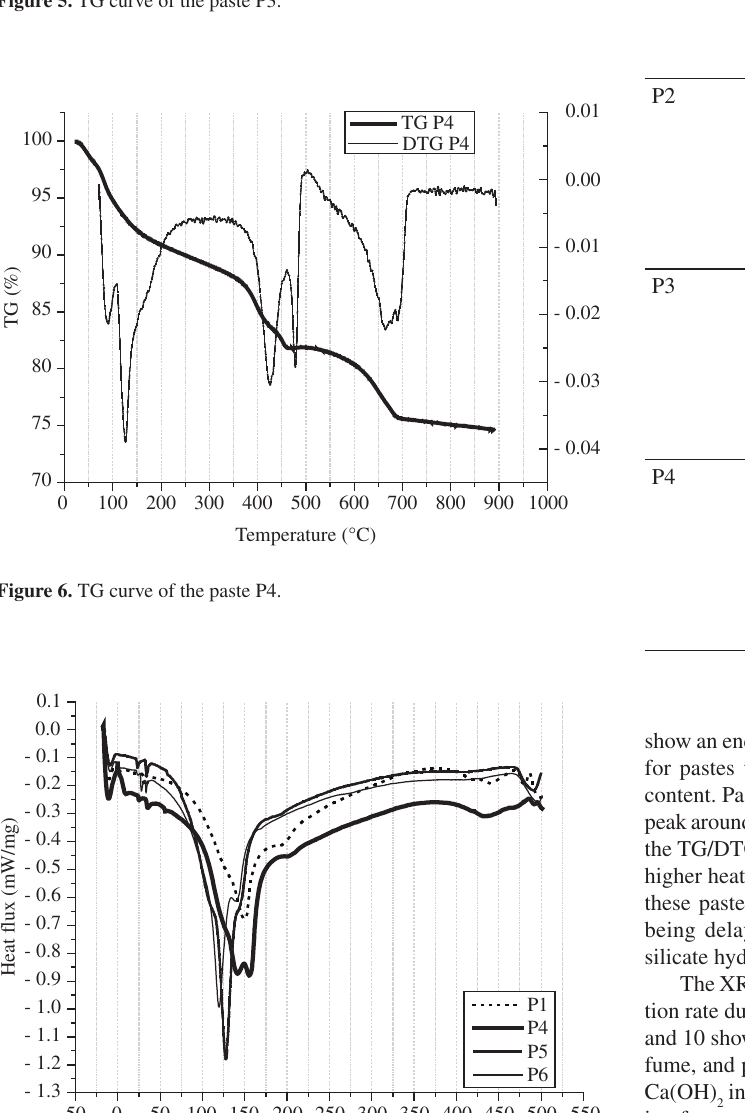
Figure 5. TG curve of the paste P3.